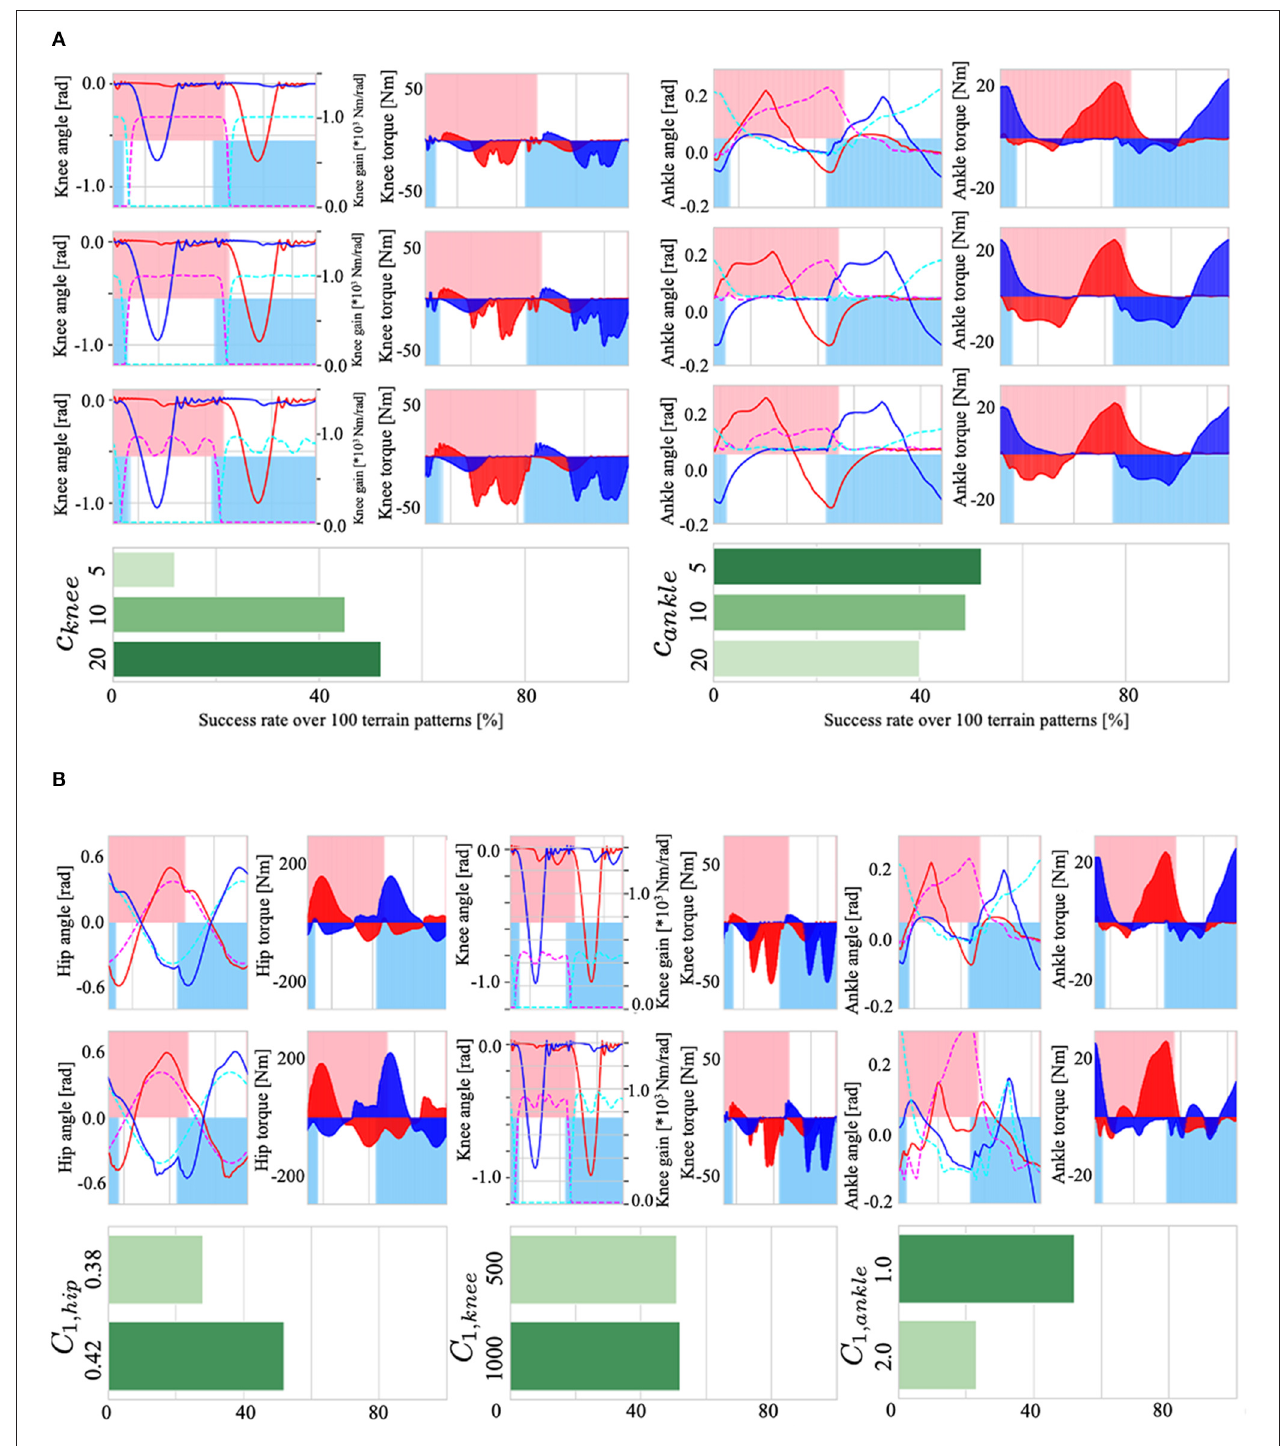
FIGURE 10 | (A) : (Left) the effect of c knee on the knee gain K knee , i , torque τ knee , i , and walking adaptability. (Right) the effect of c ankle on the ankle target angle ¯ θ ankle , i , torque τ ankle , i , and adaptability. (B) : (Left) the effect of C 1, hip on the hip joint angle θ hip , i , torque τ hip , i , and adaptability. (Center) the effect of C 1, knee on knee gain, torque τ knee , i , and adaptability. (Right) the effect of C 1, ankle on ankle joint angle θ ankle , i , torque τ ankle , i , and adaptability.